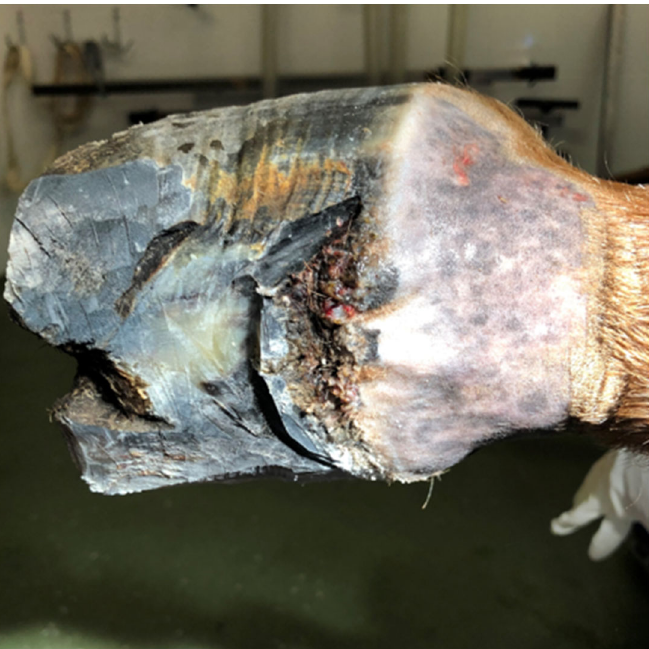
Figure 8. The appearance of the hoof during preparation for the third resection of the lesion, showing a visible dark, rough deformation within the coronary band.